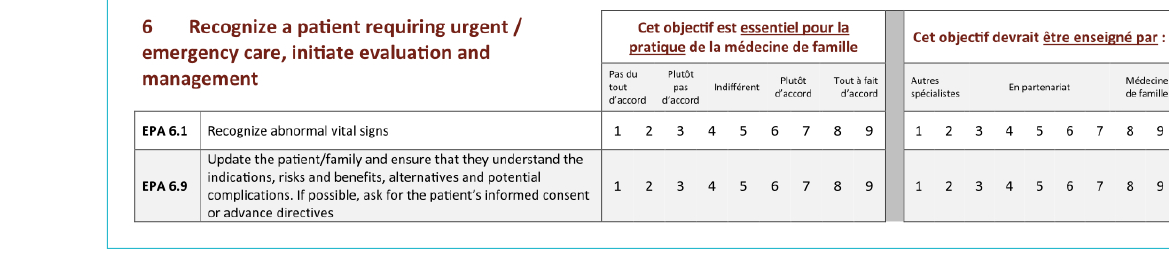
Figure 3: Example of a round 1 question. For each PROFILES item, experts were asked two questions. The first was “This objective is essen- tial to the practice of family medicine” and experts responded on a 9-point scale from 1 (“strongly disagree”) to 9 (“strongly agree”). The sec- ond was “This objective should be taught by” and a 9-point scale was provided for the response, with 1 being “by other specialists only”, 5 be- ing “by family doctorsand specialists in partnership” and 9 being “by family physicians